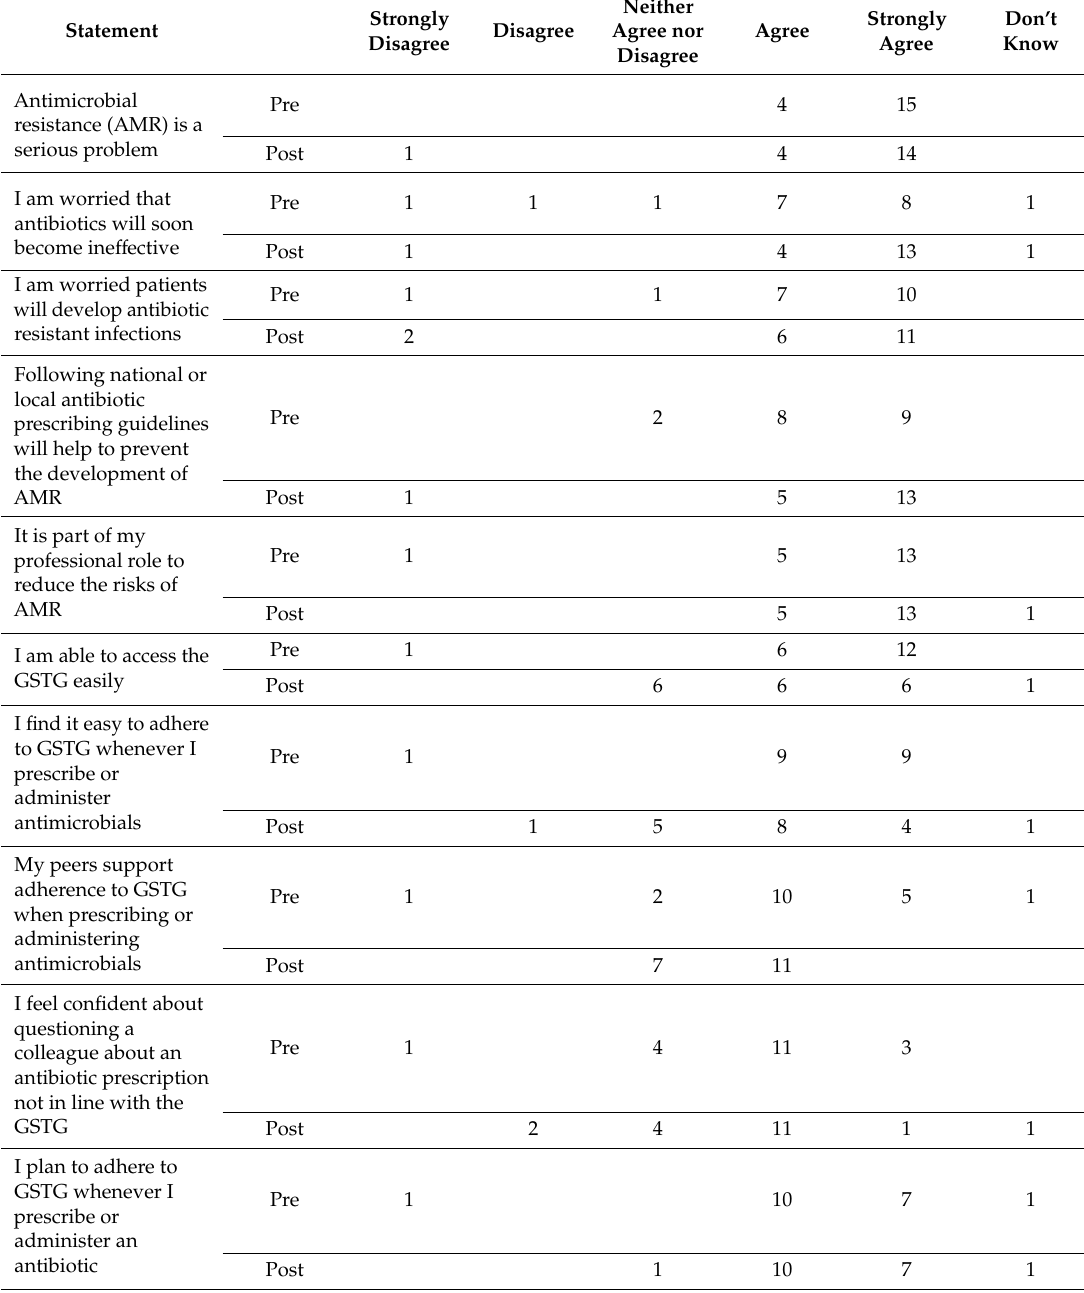
Table 3. Pre and post education responses to survey questions by sta ff at GPH (Ghana Police